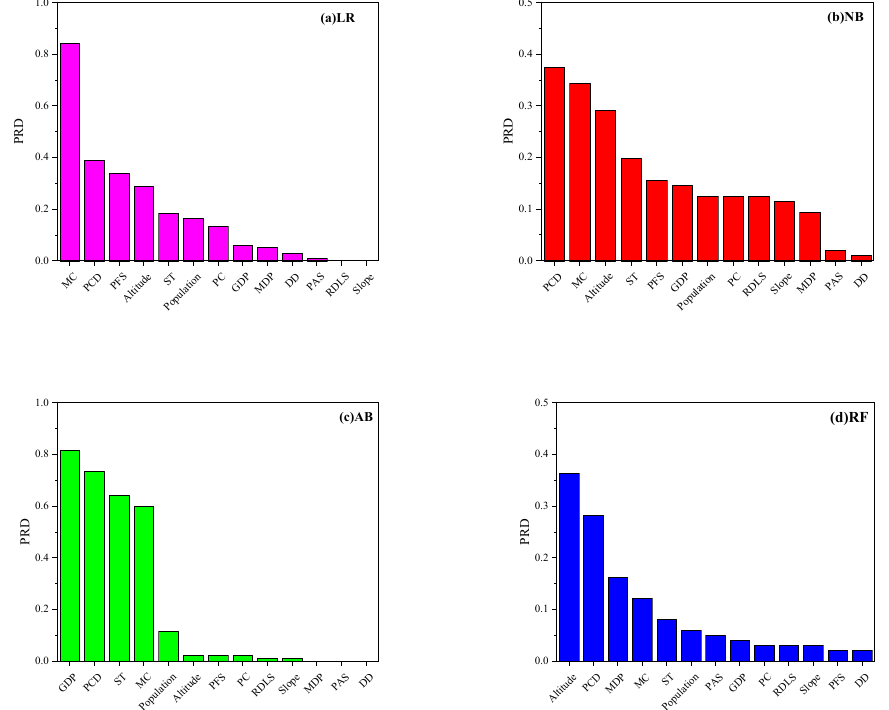
Figure 5. The percentage of relative decrease (PRD) of conditioning factors: ( a ) LR, ( b ) NB, ( c ) AB, and ( d ) RF.